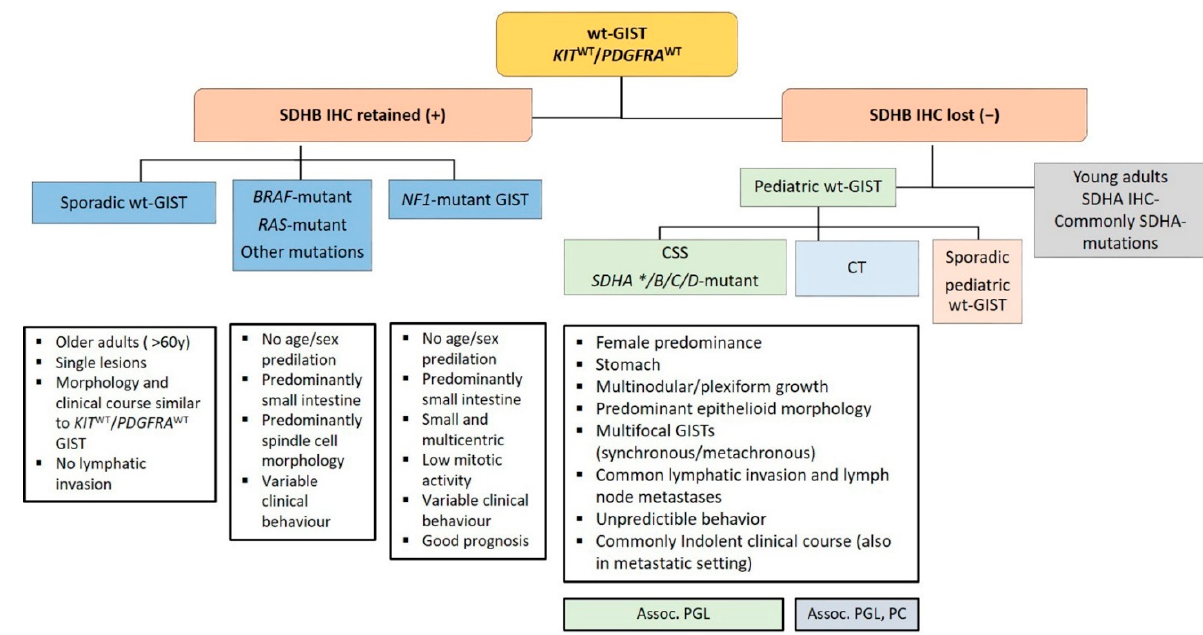
Figure 5. Diagnostic algorithm in wild-type gastrointestinal stromal tumors (wt-GISTs). Legend: Assoc.: associated; CSS: Carney–Stratakis Syndrome; CT: Carney triad; IHC: immunohistochemistry; PC: pulmonary chondroma; PGL: paraganglioma; SDHB: Succinate dehydrogenase B; wt: wild type; *: rarely reported.